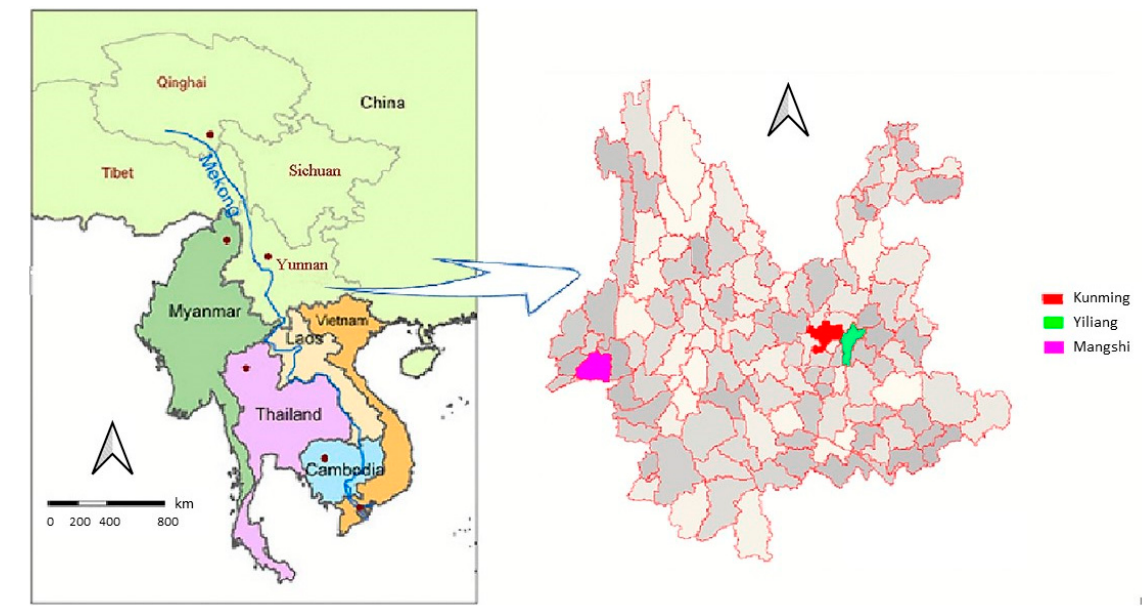
Figure 1. Location of Yiliang county and Mangshi county level city in Yunnan province of China.